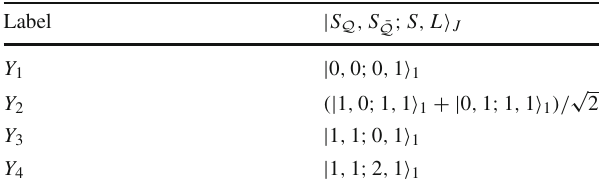
Table 1 J PC = 1 −− tetraquarks involving a diquark–antidiquark Q ¯ Q pair in P